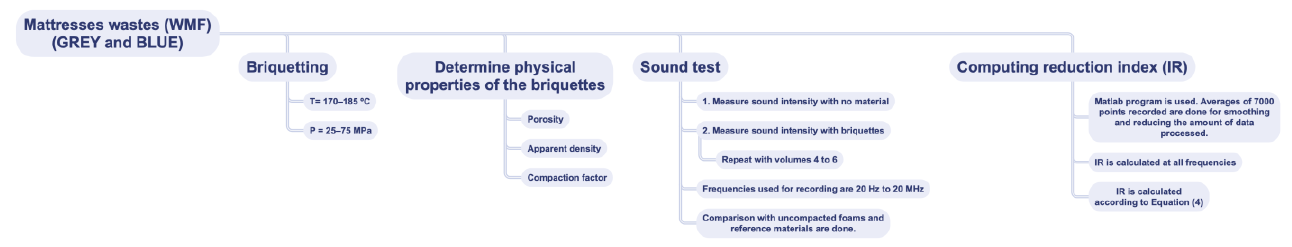
Figure 2. Workflow of the methodology followed in the present study.